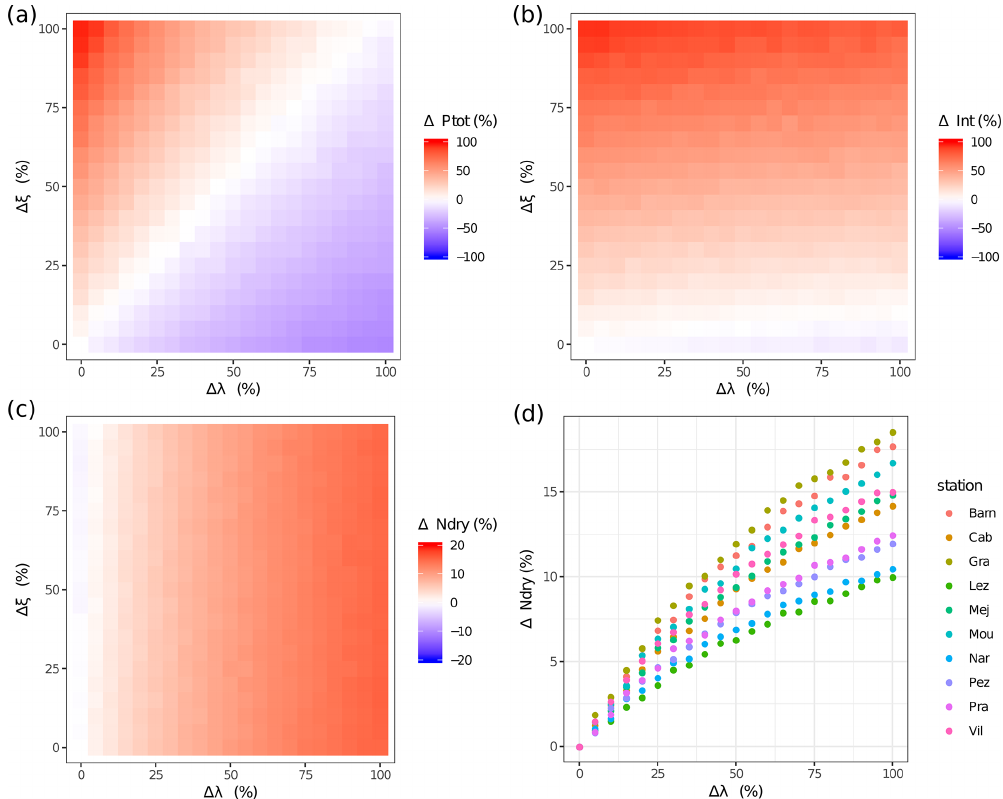
Figure 5. Impact of the perturbation of NSRP parameters λ and ξ on (a) the total annual precipitation, (b) the mean daily precipitation intensity, and (c) the annual number of dry days. Panels (a–c) show averaged results for the 10 study sites and panel (d) shows the relation between the perturbation of λ and the change in number of dry days for each station when ξ = 0. Table 3. Calibrated parameters of the SM model and NSE validation values while calibrating on the total period. Barn Cab Gra Lez Mej Mou Nar Pez